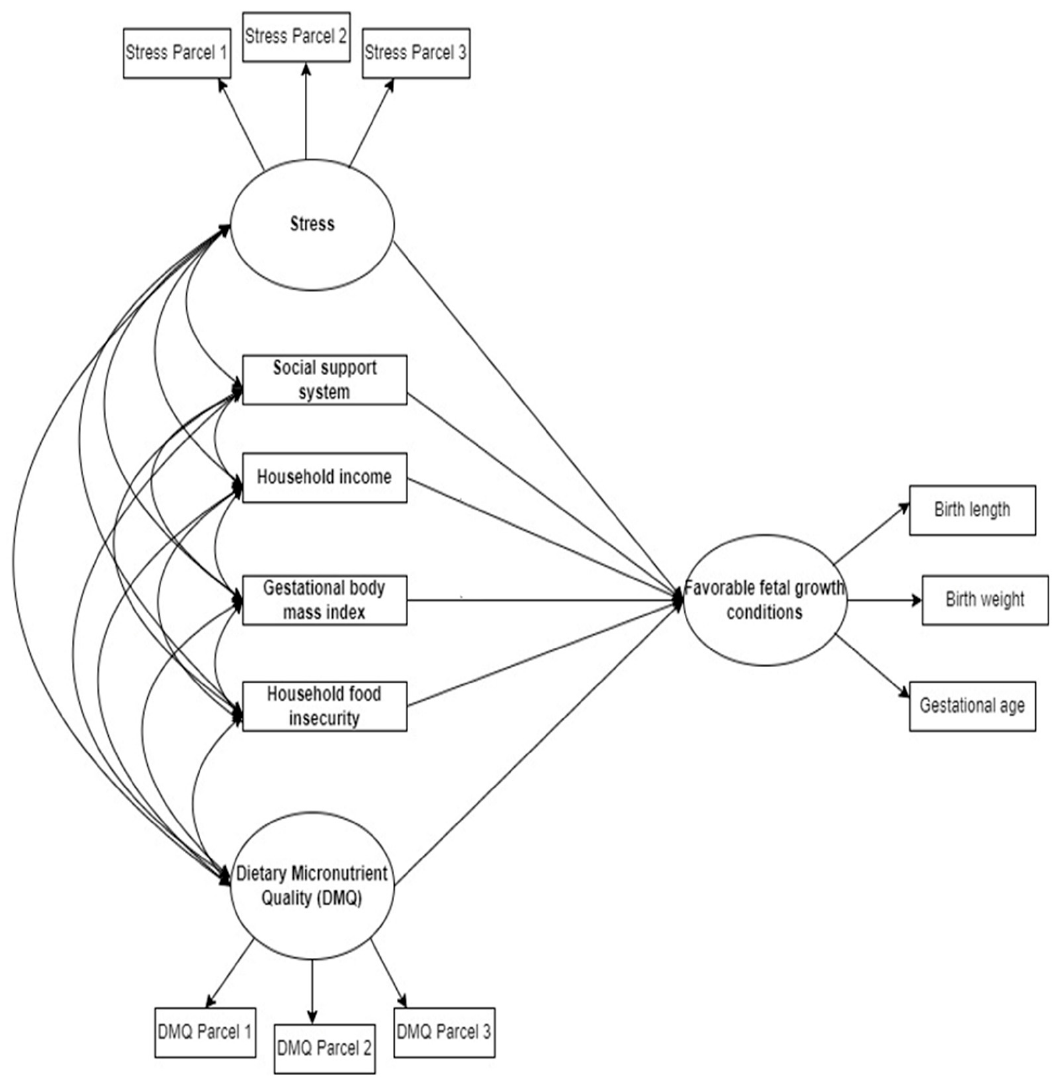
Figure 2. Hypothesized SEM of the social and nutritional factors associated with favorable fetal growth conditions in South African women.